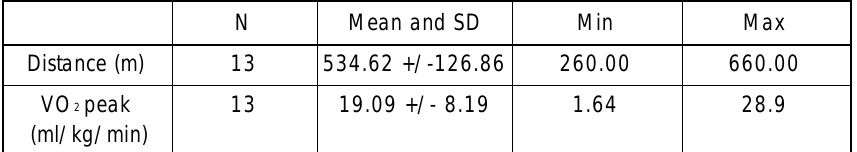
Table 3: Mean, SD, minimum value and maximum value for distance and VO 2 peak for all subjects.